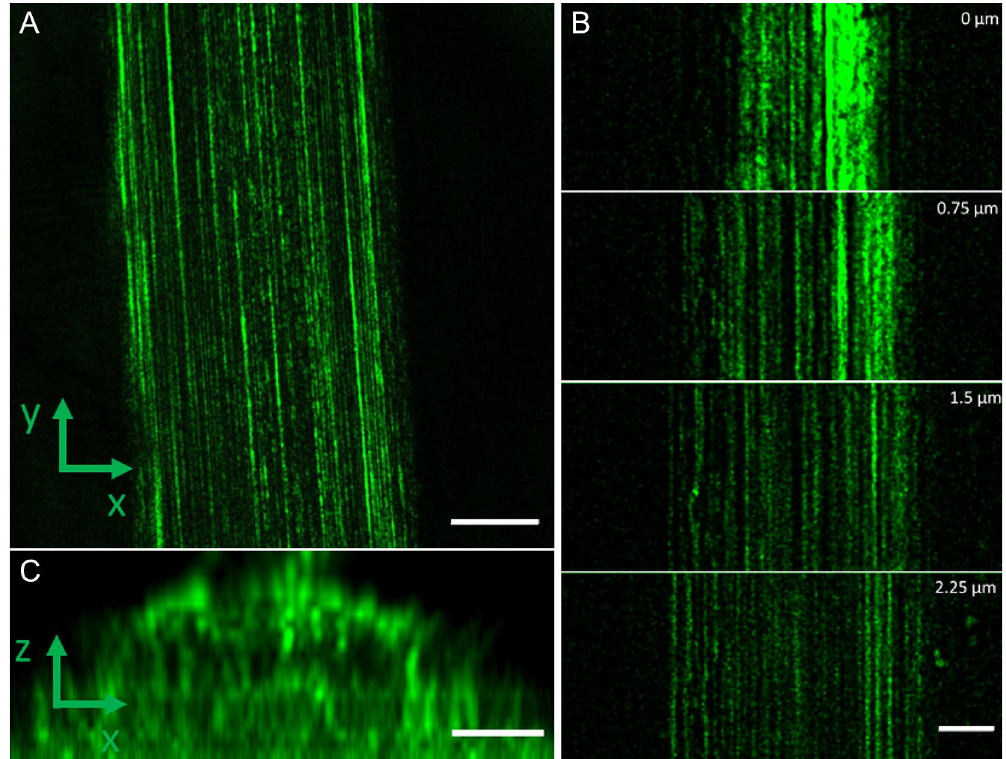
Figure 4. CRFD microscopy images of MAS spider silk fibres ( A ) Optical slice taken at the middle of a MAS fibre. Scalebar is 5 µm. ( B ) Optical sections of MAS fibre taken at different depths through the fibre. The depth is given by the number in the upper right corner of the images. Scalebar is 2 µm ( C ) Acquisition of images at different depths in z throughout the sample enabled reconstruction of a slice through the fibres in the xz plan, showing the fibre cross section. Scale bars 2